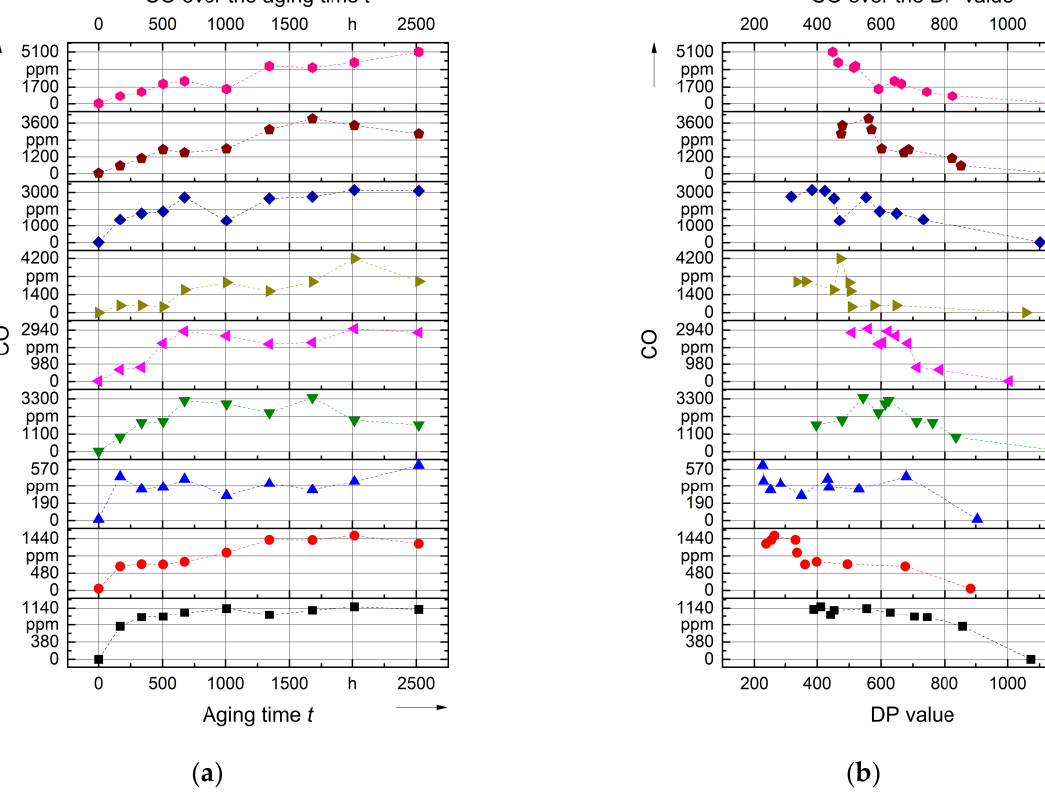
Figure 7. Change of CO concentration for different sealing systems and fluids: ( a ) Change over the aging time; ( b ) Change over the DP value; the legends refer to Figure 6a.